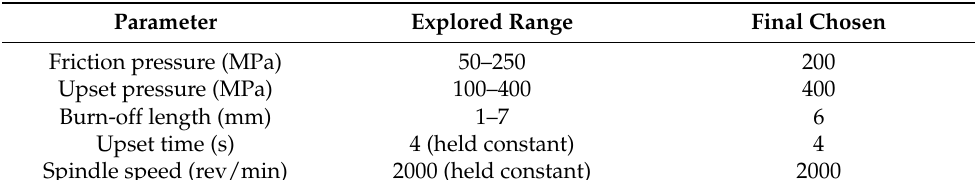
Table 2. Welding parameters.